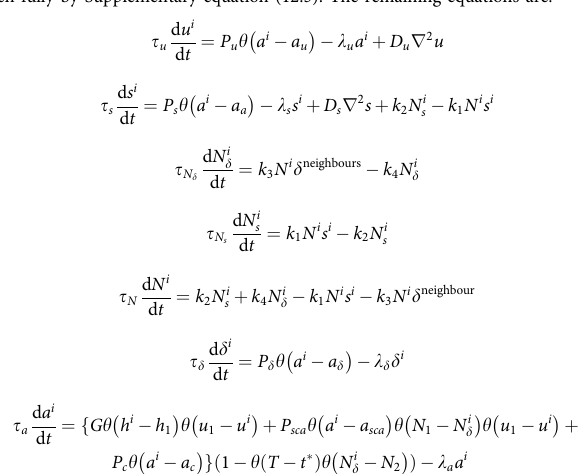
Numerical approach and parameters . Equations were solved by a custom- written Matlab programme implementing an explicit forward Euler method. See Supplementary Methods for detailed simulations. The equations for the extended network described in Fig. 4 describe the full selection dynamics: starting with the formation of clusters and continuing with their refinement to a single selected cell. These equations are discussed in length in Supplementary Note 7. The equation for h is the same as in Figs 1 and 3 and is given fully by Supplementary equation (12.3). The remaining equations